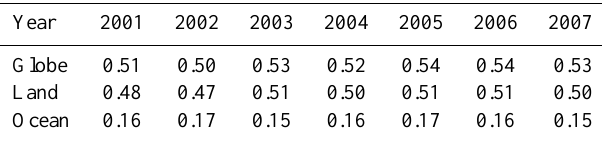
Table 3. The uncertainties of optimized fluxes for the globe, land and ocean by GCAS-DOM (in PgCyr − 1